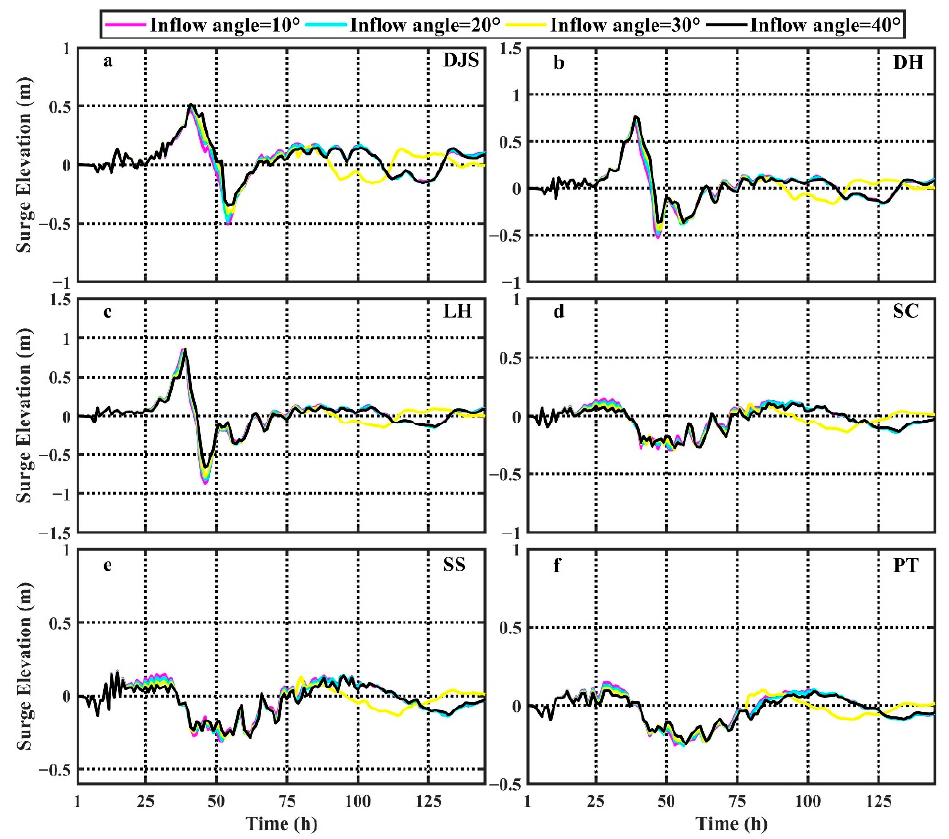
Figure 8. Time series of surge elevation in experiments with different inflow angle at: ( a ) DJS, ( b ) DH, ( c ) LH, ( d ) SC, ( e ) SS, and ( f ) PT station.